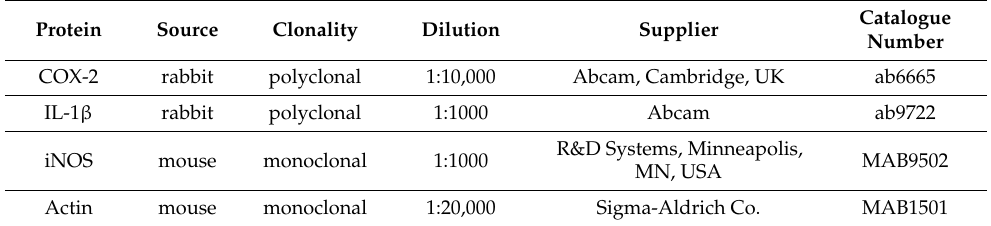
Table 3. List of primary antibodies used in Western blot assays.